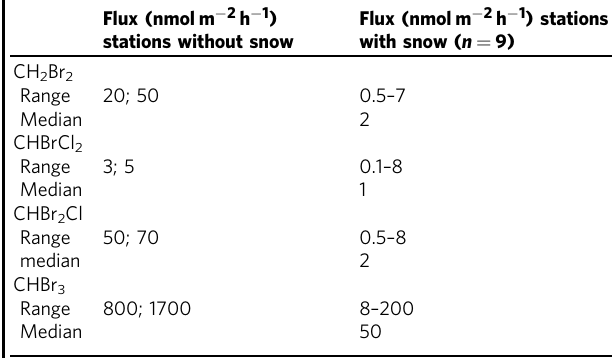
Table 1 Estimated fl ux of bromocarbons from sea ice